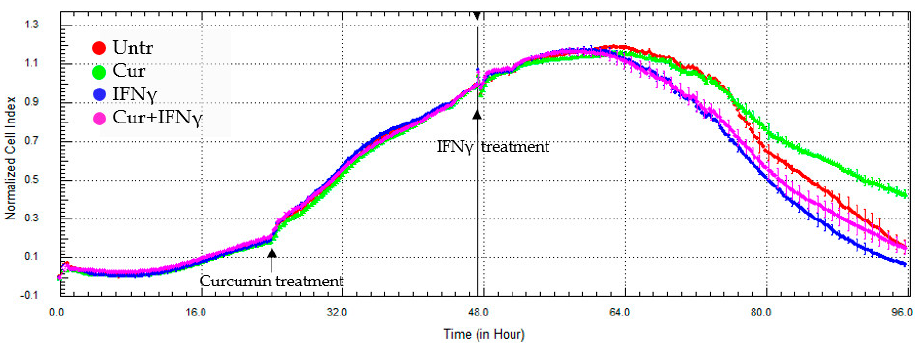
Figure 5. Representative impedance profile after curcumin pre-treatment. HT29 cells, cultured in a 16-well E-plate, were pre-treated with curcumin (Cur, 24 h after seeding), and stimulated with IFN γ (48 h after seeding) for a further 48 h. The graph shows the cell index values, normalized at the time of the IFN γ stimulation. The experiment was performed in triplicate.